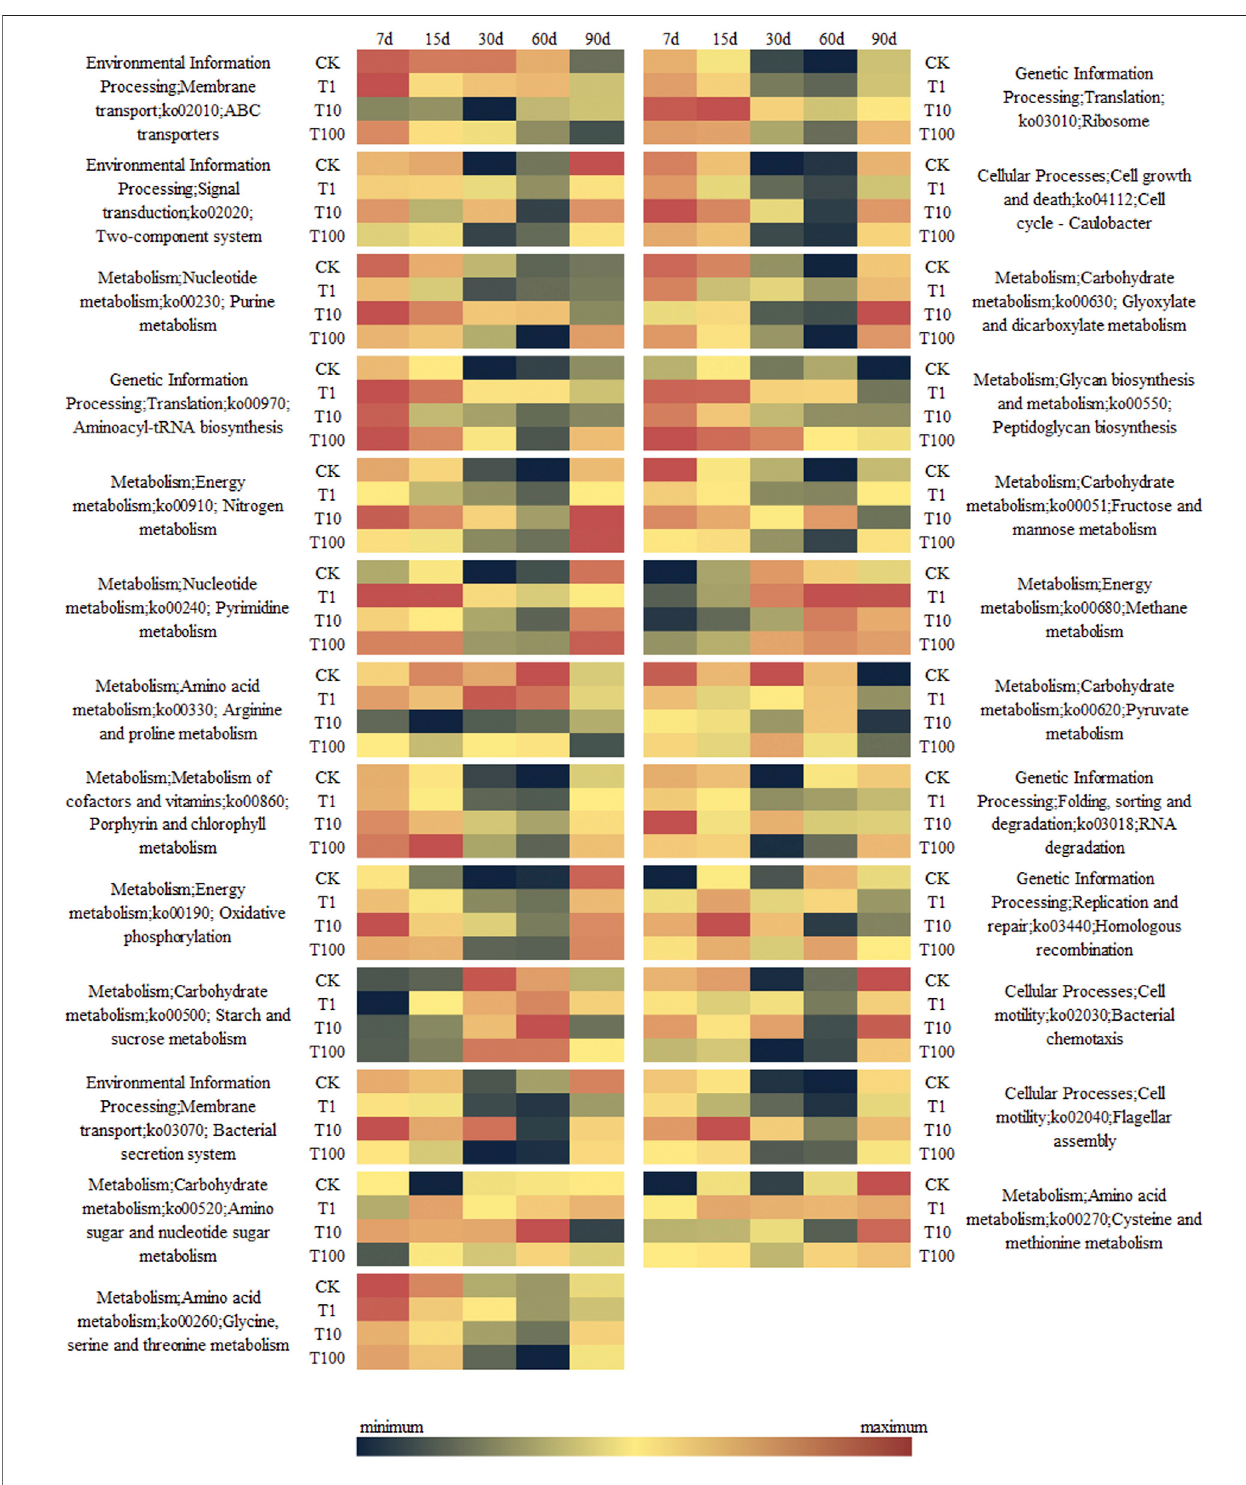
FIGURE 4 | Heatmap of pathways predicted by Tax4Fun.